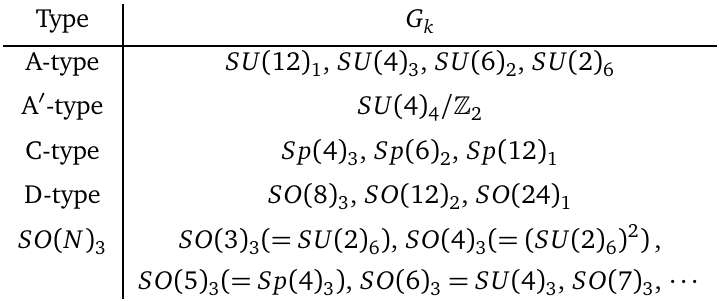
Table 1: List of WZW models that allows fermionization to supersymmetric models with super- symmetric vacua.